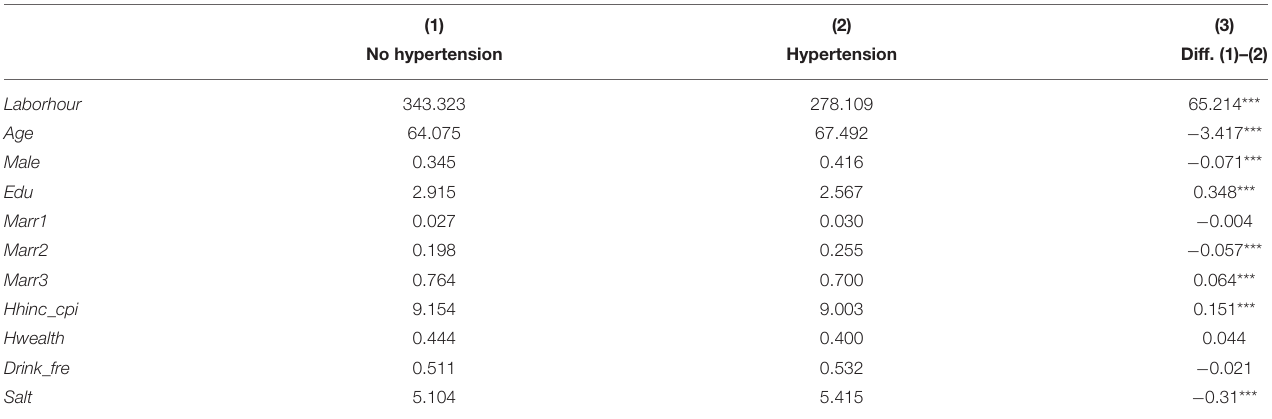
TABLE 2 | T -test for the differences between the elderly with hypertension diagnosed or